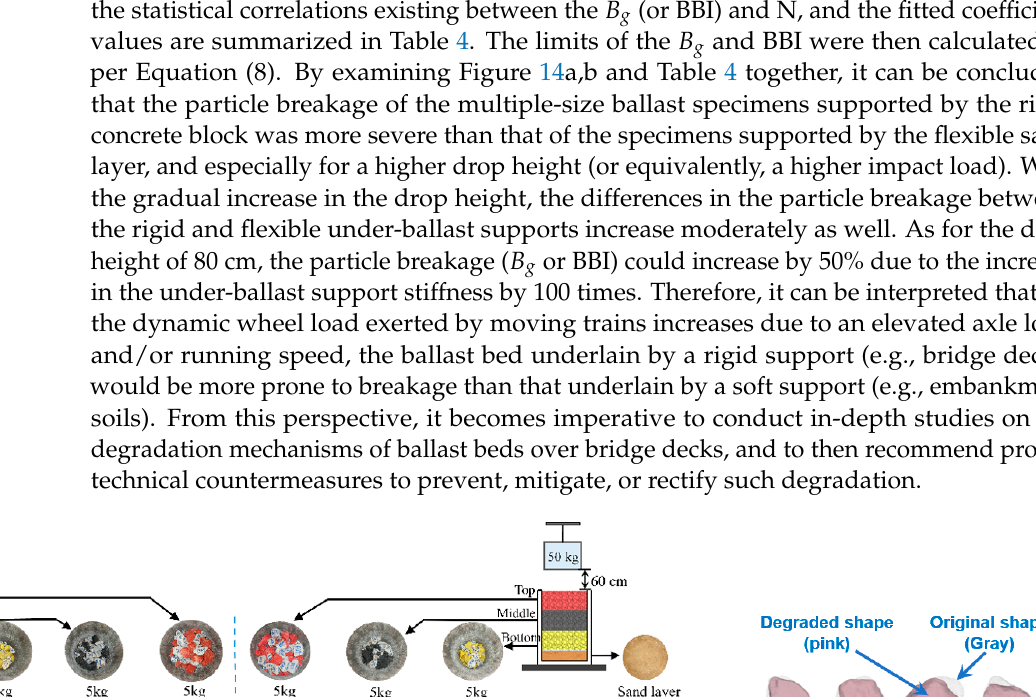
Figure 13. Photos of particle abrasion and crushing trends among different layers of multiple-size ballast specimens supported by a rigid concrete block and relatively soft sand layer under a 60 cm drop